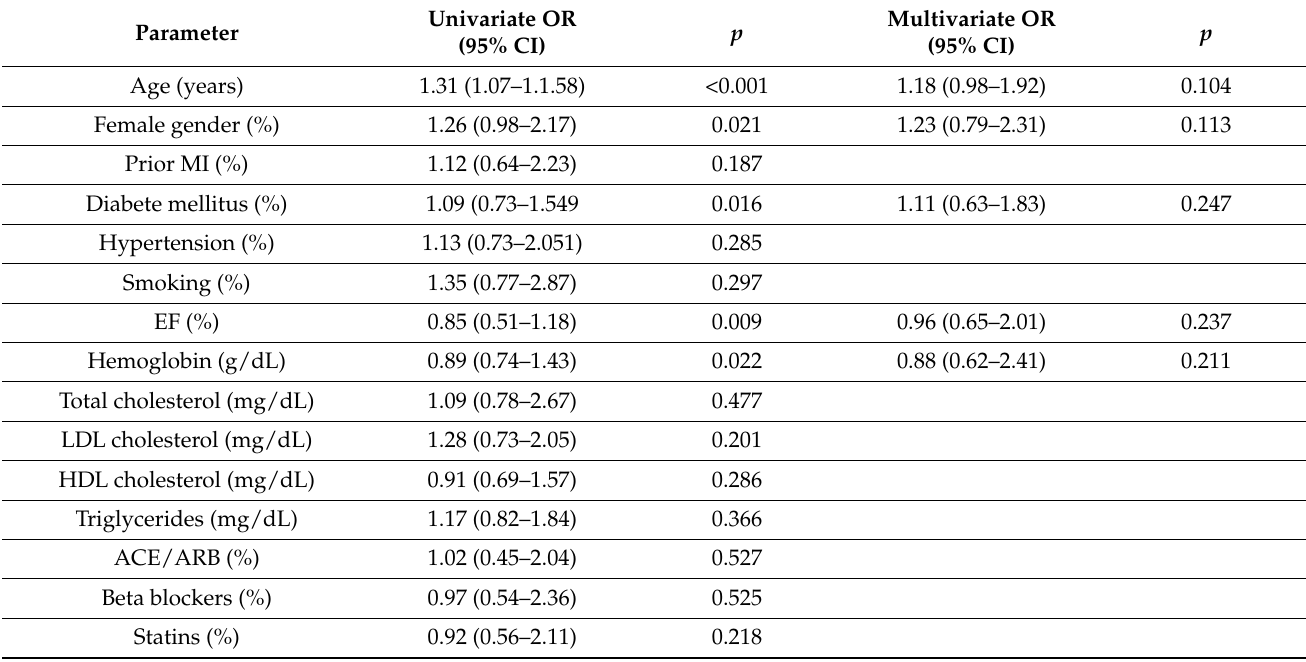
Table 2. Predictors of contrast-induced